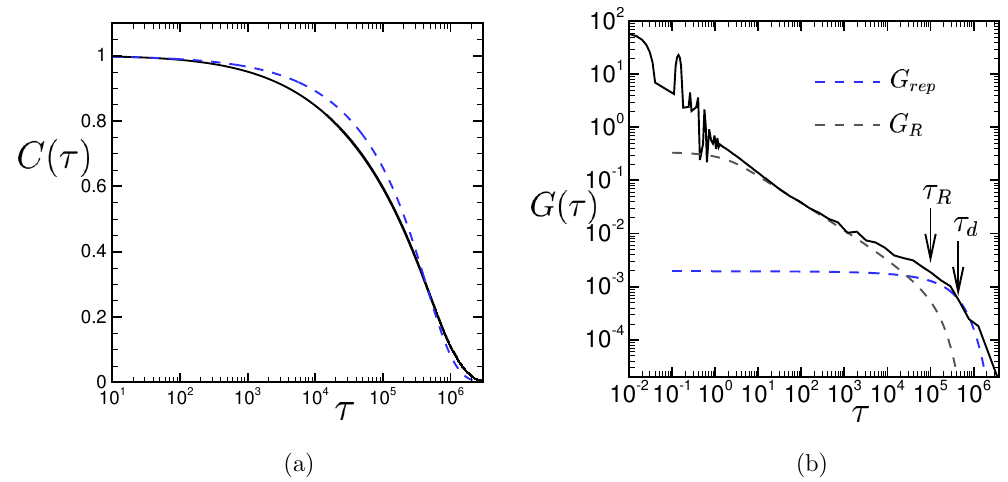
Figure 2. ( a ) The time-correlation function of the end-to-end vector of polymer chain C ( τ ) defined in Equation (4) and ( b ) the stress relaxation function G ( τ ) defined in Equation (5). In ( a ), the blue dashed line shows the theoretical formalism of the reptation dynamics with the relaxation time τ d = 4.4 × 10 5 . In ( b ), the theoretical formalism of the stress relaxation function for the Rouse dynamics, G R ( τ ) in Equation (7), and for the reptation dynamics, G rep ( τ ) in Equation (8), are also